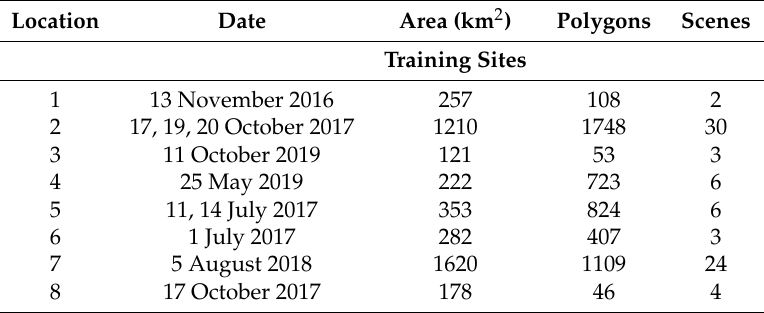
Table 1. Details of the labeled data as shown in Figure 2. Scenes show the number of PlanetScope scenes mosaicked together to cover the area of